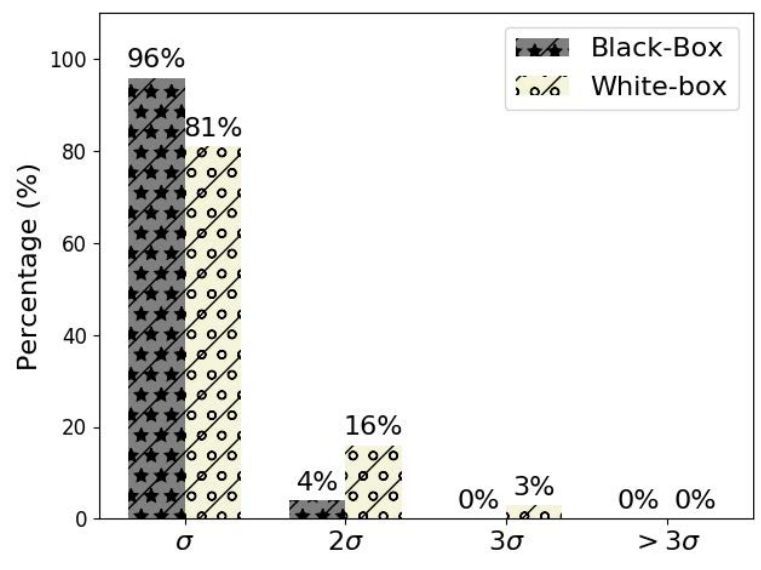
Figure 6. Bar chart of the percentage of measured BC data points within three levels of the confidence interval ( σ ) of the estimated BC.